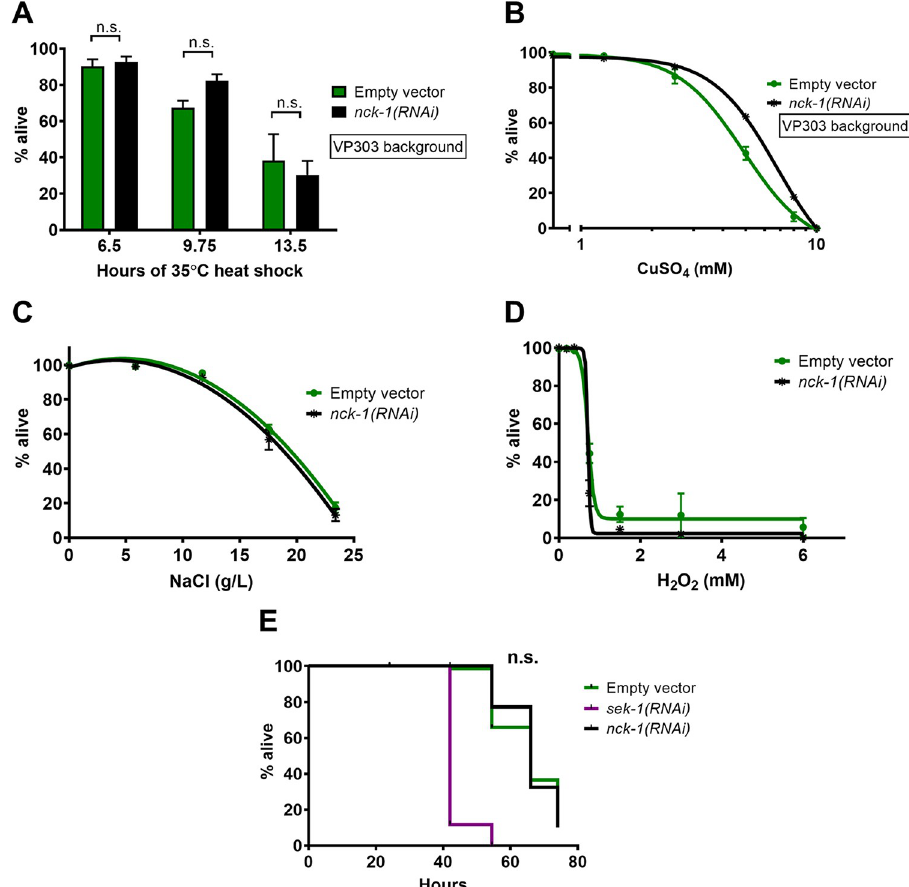
Fig 3. nck-1 loss does not affect sensitivity to other stressors. (A) VP303 (intestinal-specific RNAi) C . elegans L4 animals grown on RNAi bacteria were incubated at 35˚C, with survival determined at each indicated time-point. (B) VP303 L4 animals grown on the indicated RNAi bacteria were transferred to liquid culture with varying amounts of CuSO 4 for 6 days at 25˚C. (C and D) Wild-type N2 C . elegans grown to the L4 stage on the indicated RNAi were transferred to liquid culture with varying amounts of (C) NaCl for 6 days or (D) H 2 O 2 for 4 hours, before survival was measured. (E) Wild-type C . elegans grown to the L4 stage on the indicated RNAi were transferred to plates spread with Pseudomonas aeruginosa PA14 and survival was followed over the indicated time. For (A), each data point is the average of three independent experiments with one plate/experiment (n = 40–50 worms/plate). For (B), (C), and (D), each data point is the average of three independent experiments with three wells/experiment (n = 27–29 worms/well). The data in (E) are a single representative of three independent trials with comparable results (n = 90 animals/ genotype). Logrank analysis shows no significant difference in survival between empty vector and nck-1(RNAi)